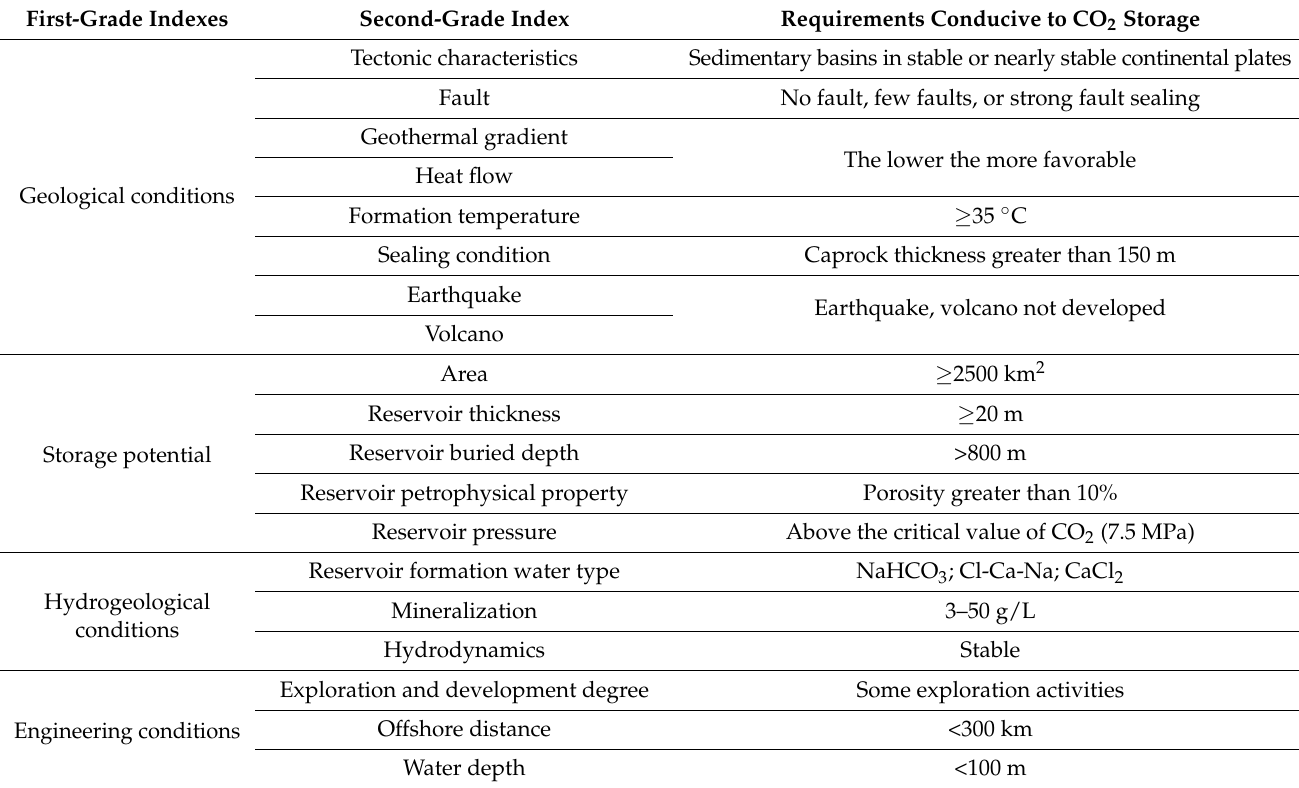
Table 2. CO 2 geological storage suitability evaluation index system.